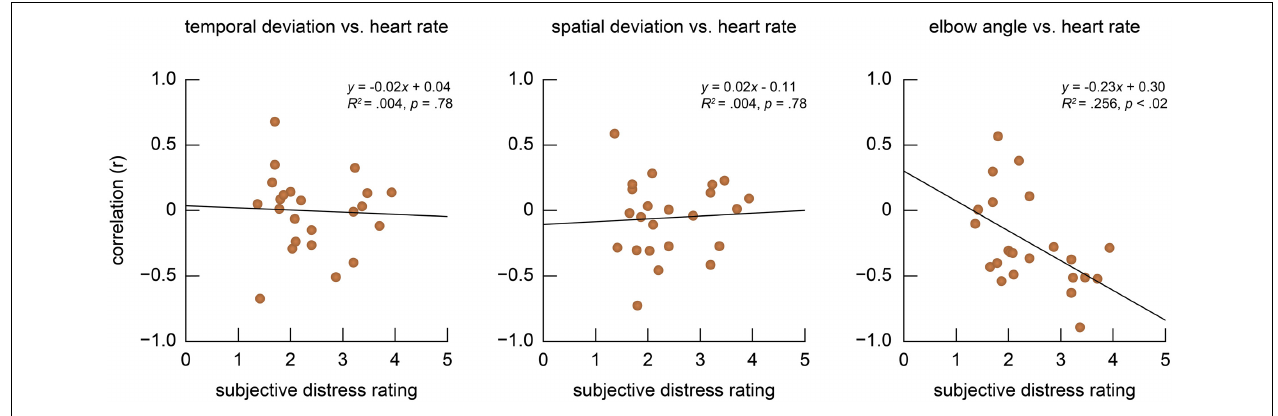
FIGURE 5 | Individual differences in the correlation between the physiological measure (i.e., heart rate) and behavioral measures in the Panel stage. Those who reported the task as more anxiety-provoking